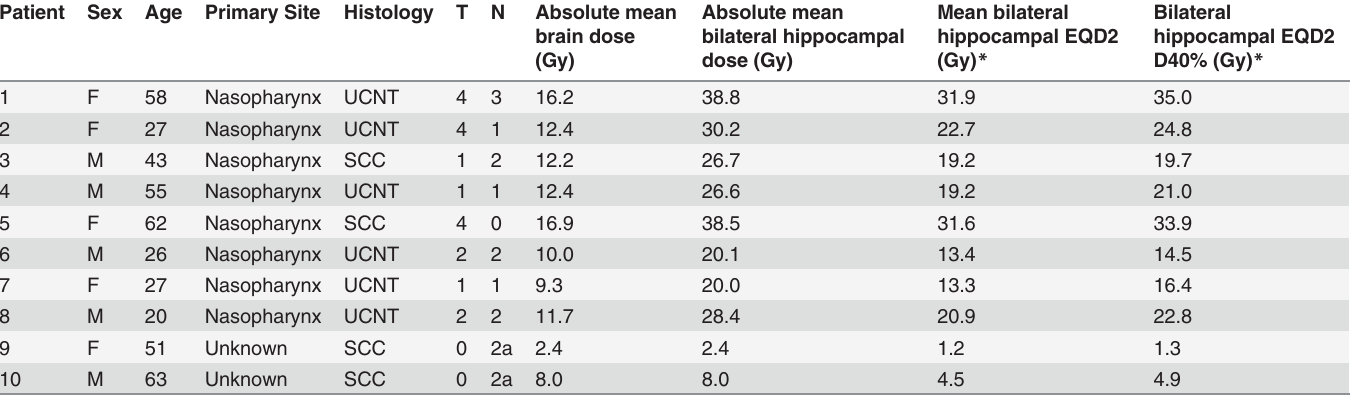
Table 1. Patient